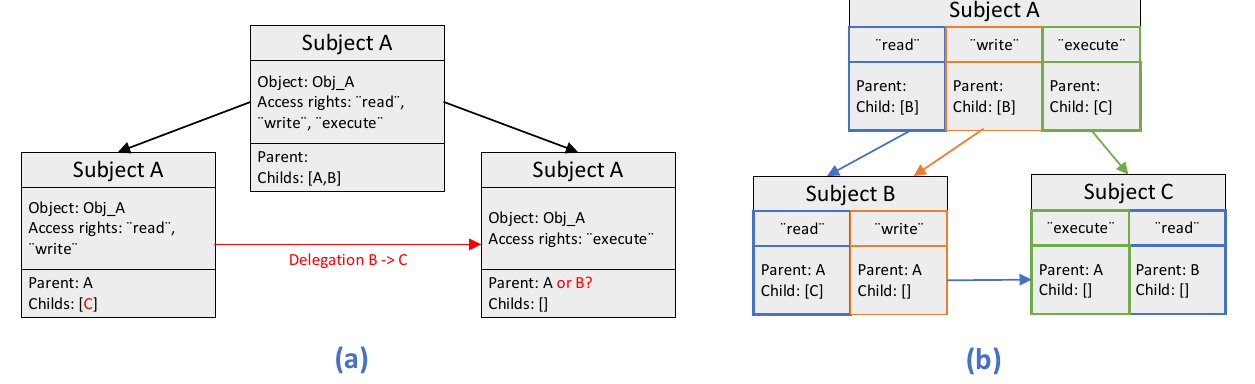
Figure 11. ( a ) Delegation tree, and ( b ) Delegation graph.